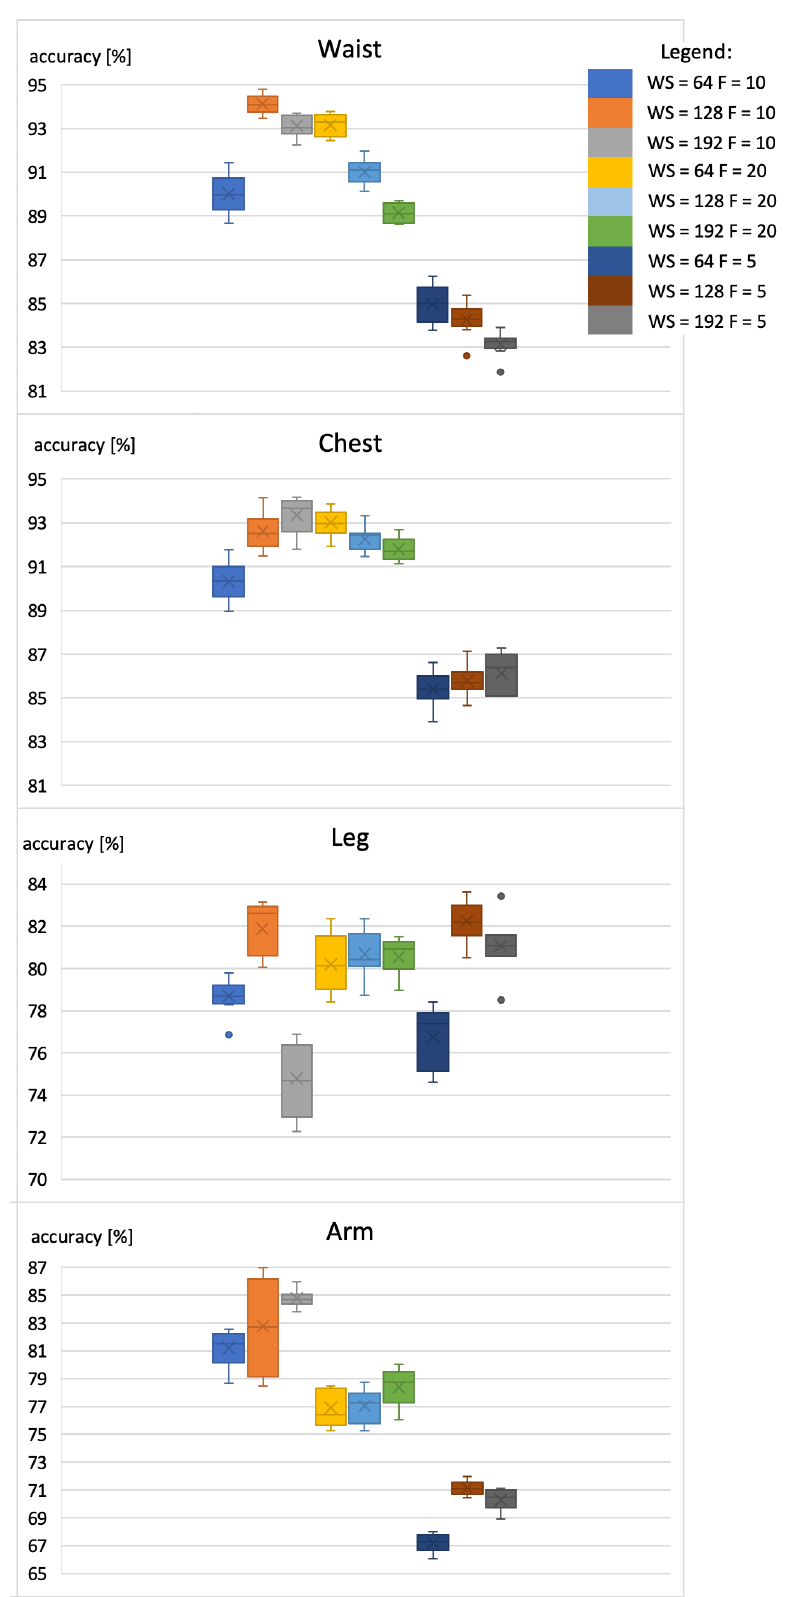
Figure 6. Accuracy of standard activities recognition using the smartphone with the RNN